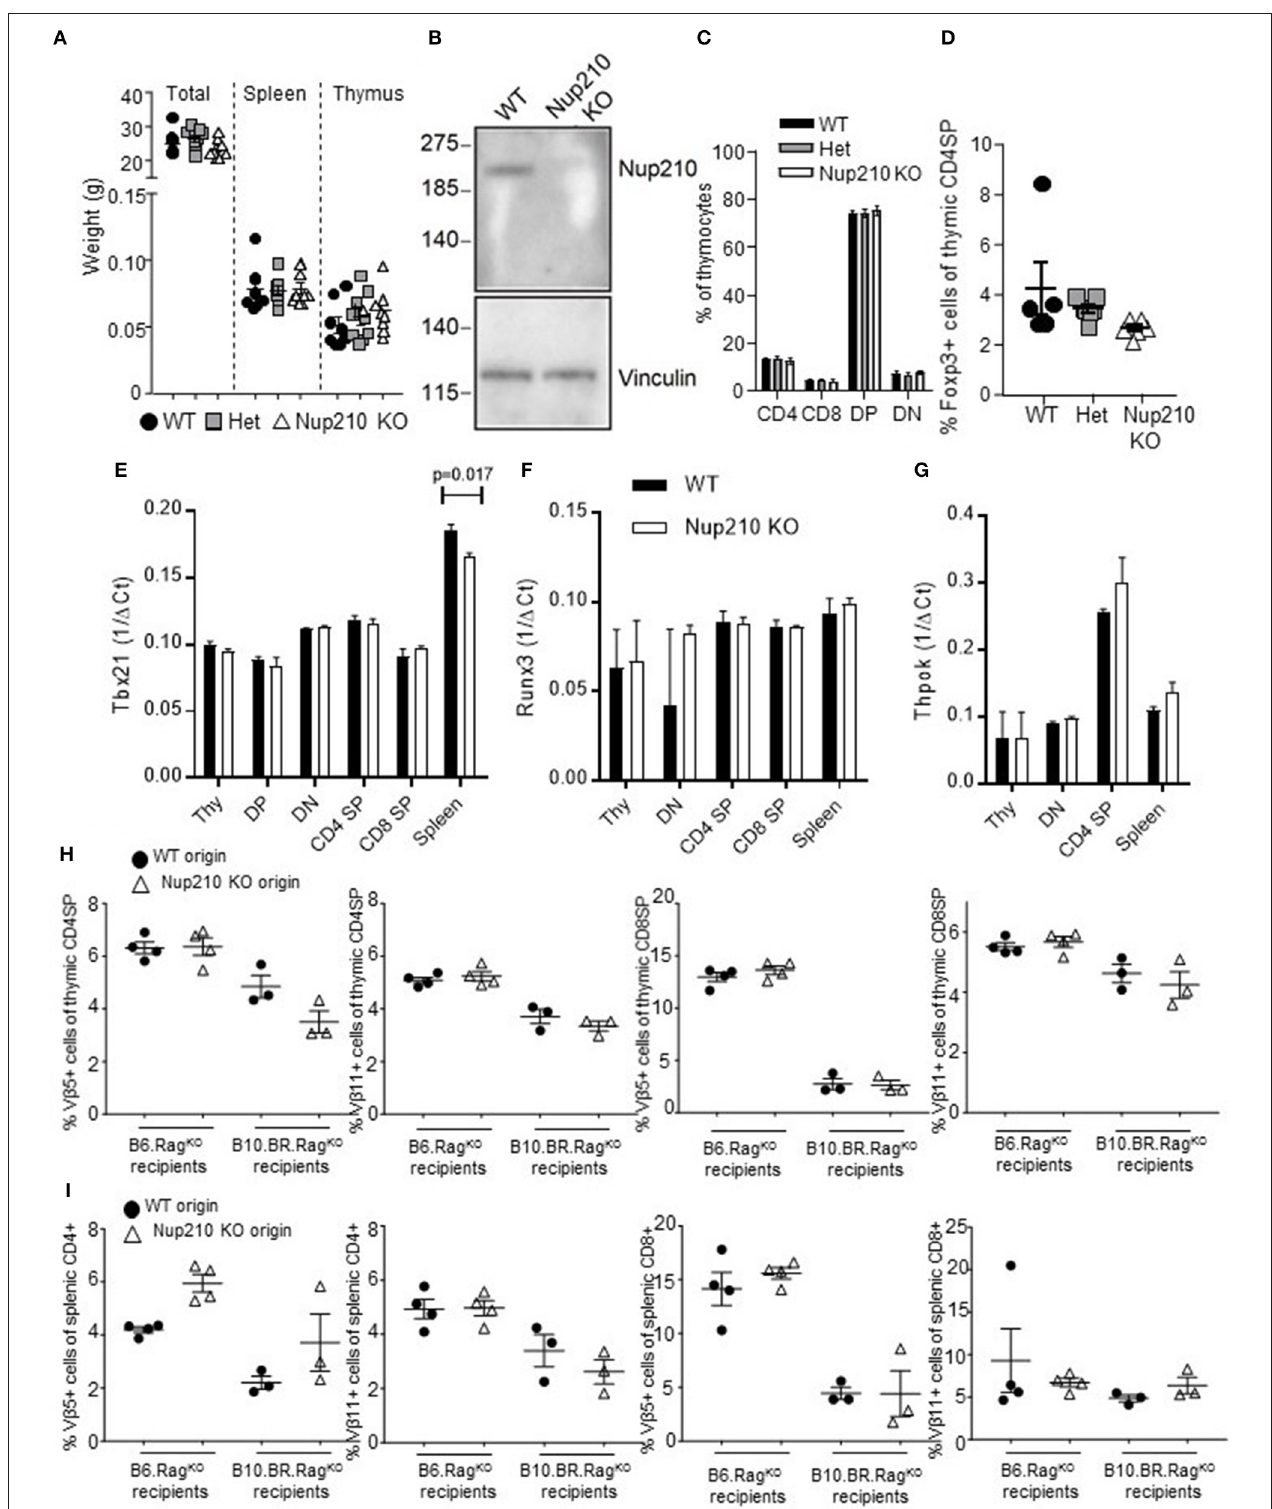
FIGURE 2 | Nup210 knockout mice are viable and have intact thymic biology. (A) Six to 11 week old wildtype, Nup210 het , Nup210 KO mice were analyzed for body weight, spleen weight and thymus weight ( n = 8, 9, 9). (B) Western blot for Nup210 in the lysates of wildtype and Nup210 KO thymocytes. Vinculin was used